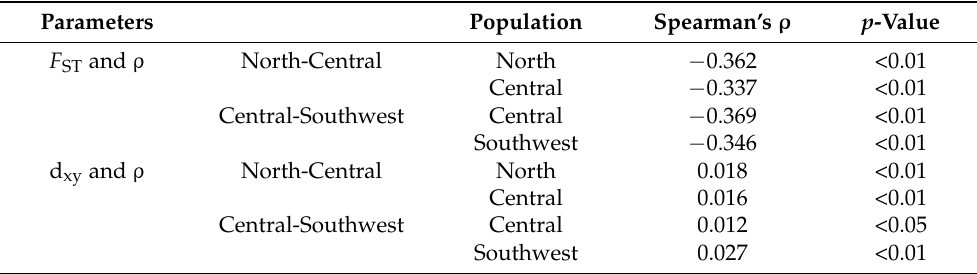
Table 2. Spearman’s rank correlation coefficient. Correlation coefficient between the relative measure of divergence ( F ST ) and recombination rate ( ρ ), as well as between absolute divergence (d xy ) and recombination rate ( ρ